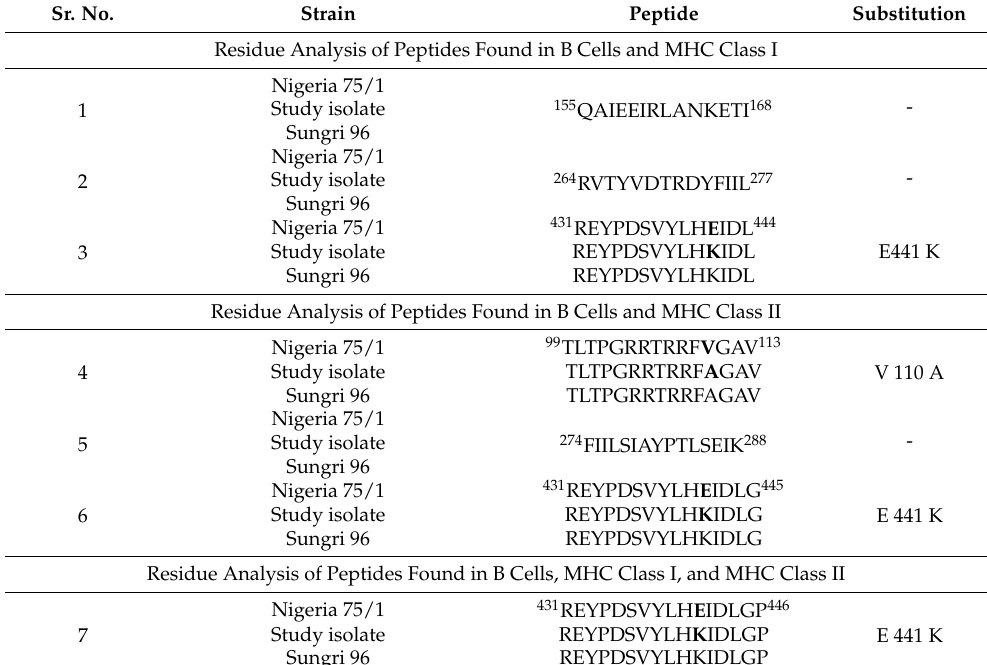
Table 2. Comparative mutational analysis of fusion protein of studied isolates and vaccinal strains (Nigeria 75/1 and Sungri 96).